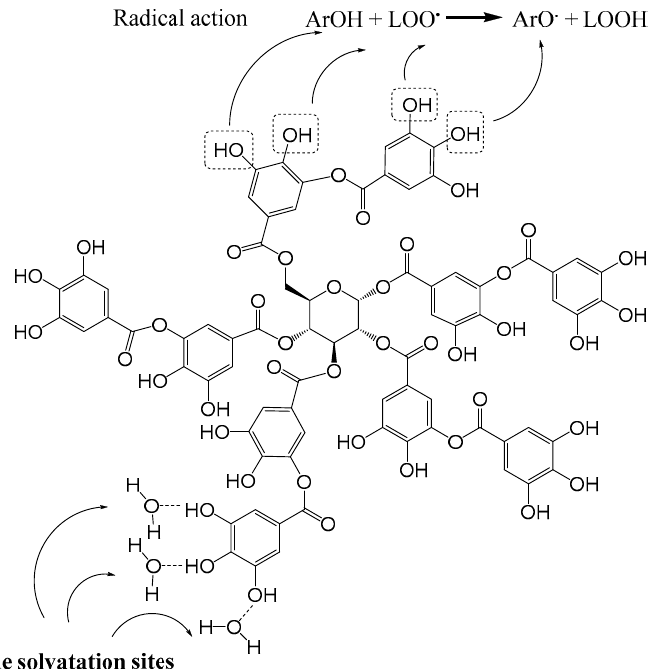
Figure 1. Chemical formula of tannic acid. Tannic acid has numerous phenol groups supporting a high solubility in aqueous solutions and a great antioxidative capacity. The phenolic groups (ArOH) give electrons to different radicals (LOO°) formed during ischemia–reperfusion and the radical tannic acid produced (ArO°) remains stable and not reactive linked to tautomeric forms produced from the benzenic group.